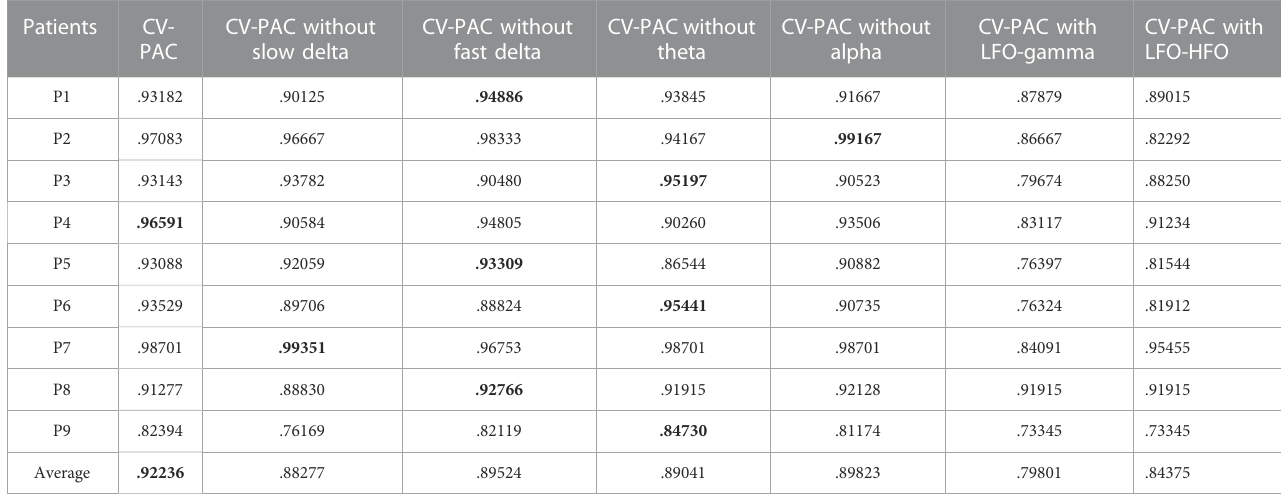
TABLE 2 AUC values using CV-CNN on CV-PAC.